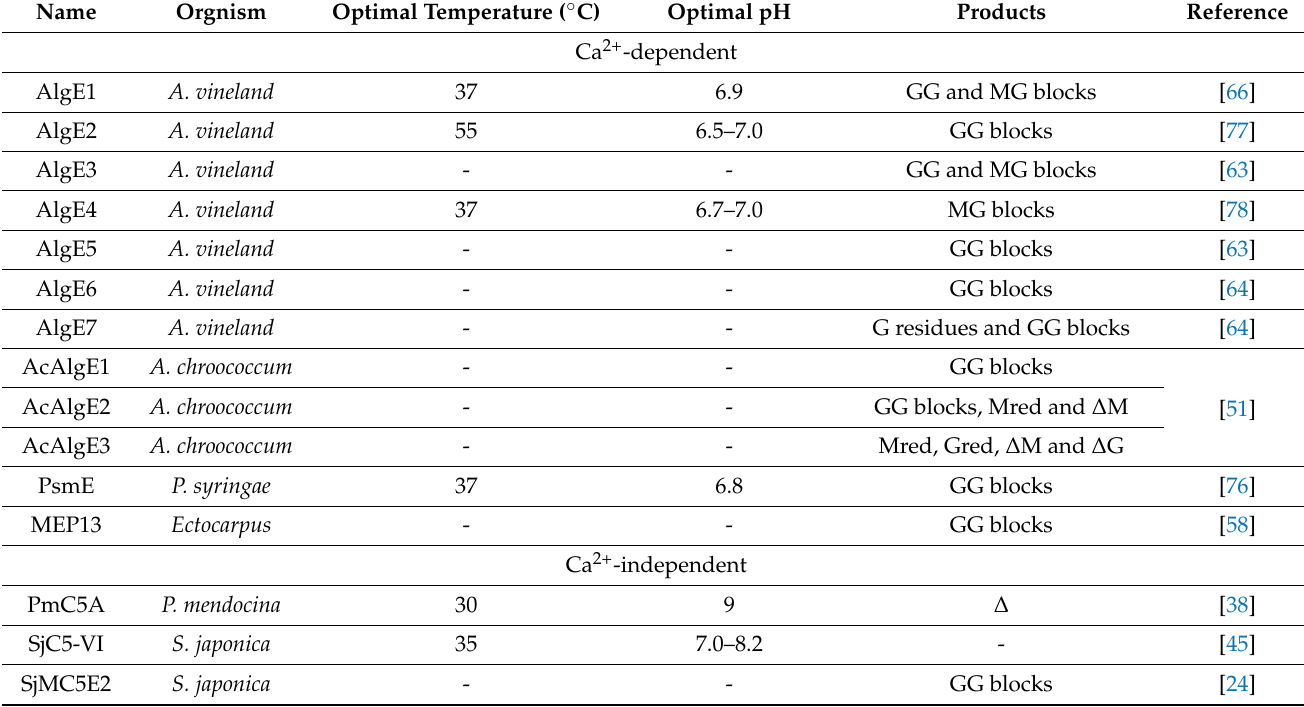
Table 2. Main characteristics of the reported ManC5-Es from various